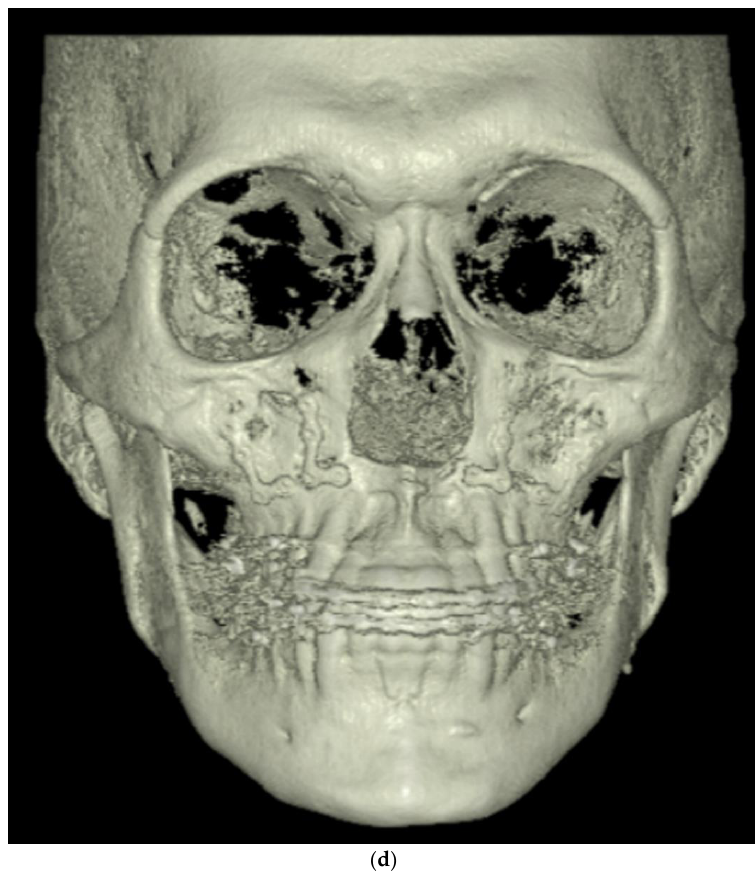
Figure 2. Virtual surgical simulation superimposed on a scanned dental cast: ( a ) pre-operative condition, ( b ) surgical simulation; and postoperative outcome ( c ) one month post-operatively, ( d ) one year post-operatively.